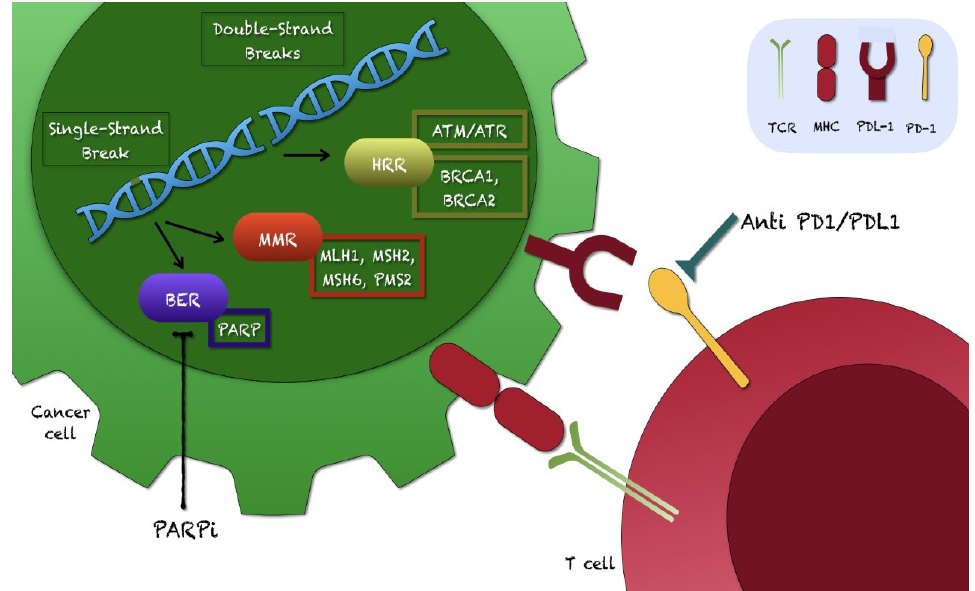
Figure 2. Intracellular DNA damage repair pathways (BER: base excision repair; HRR: homologous recombination repair; MHC: major histocompatibility complex; MMR: mismatch repair system protein; PARP: poly-ADP-ribose polymerase; PARPi: PARP inhibitors; TCR: T-cell receptor).